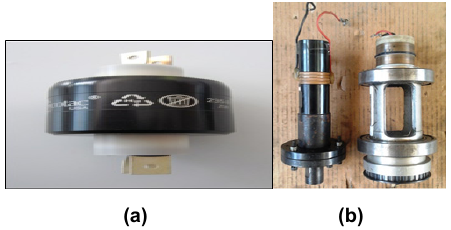
Figure 1. Experimental set-up of ultrasonic-assisted drilling process